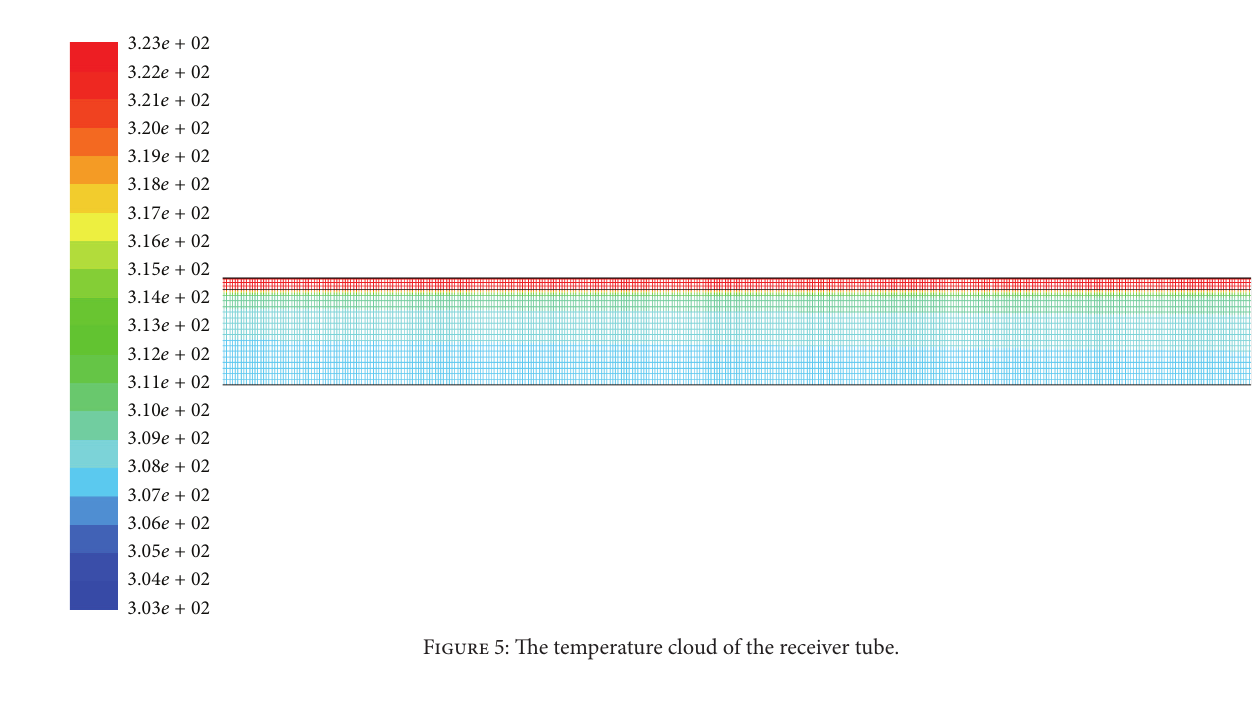
Table 3: Experimental